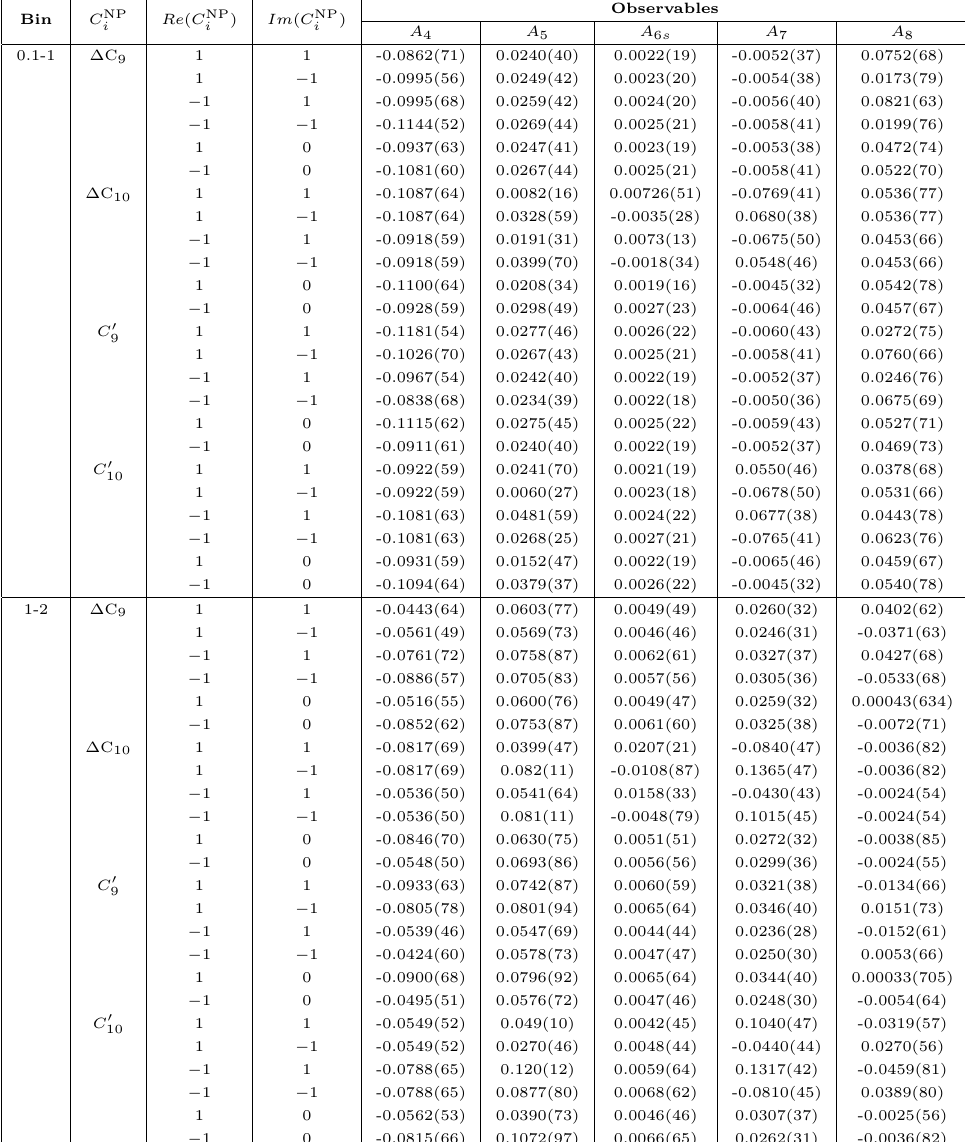
Table 20 . The dependence of the asymmetric observables corresponding to B ± → ρ ± ll on the real and imaginary parts of the NP WC’s ∆ C few benchmark values of the real and imaginary parts of the corresponding